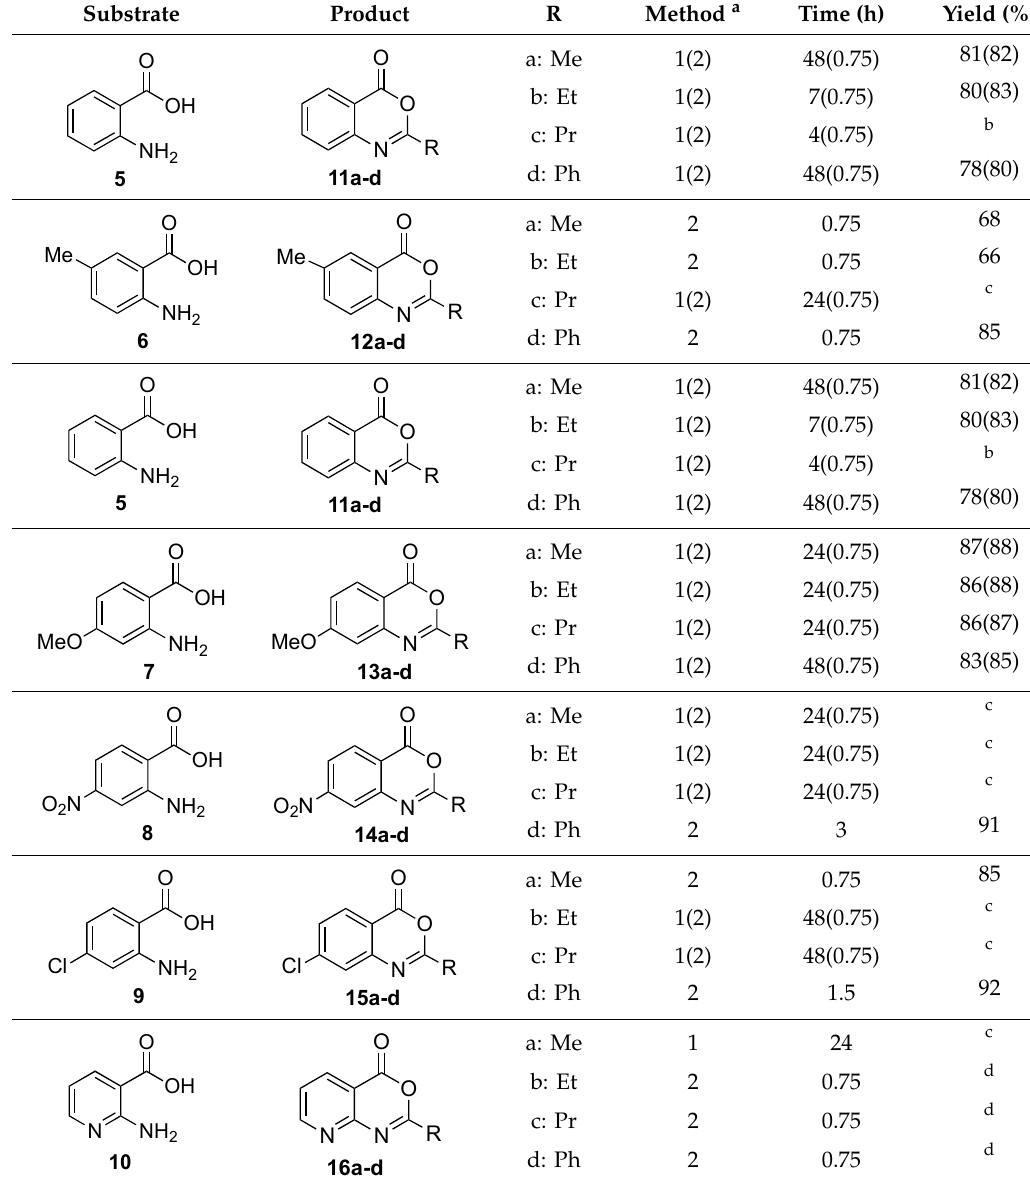
Table 1. Formation of 4 H -benzo[ d ][1,3]oxazin-4-ones.